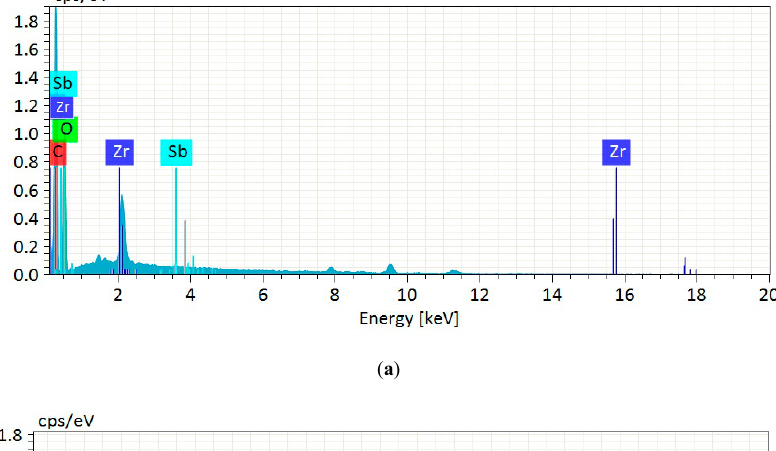
Figure 1. Micrographs of ( a,b ) bleached fibrefiber (CPBLH), ( c,d ) alkali-treated fibrefiber (CPAKL), and ( e,f ) microcrystalline cellulose (CPMCC) with magnifications of x100 ( a,c,e ) and x3000 ( b,d,f ) under SEM viewing.